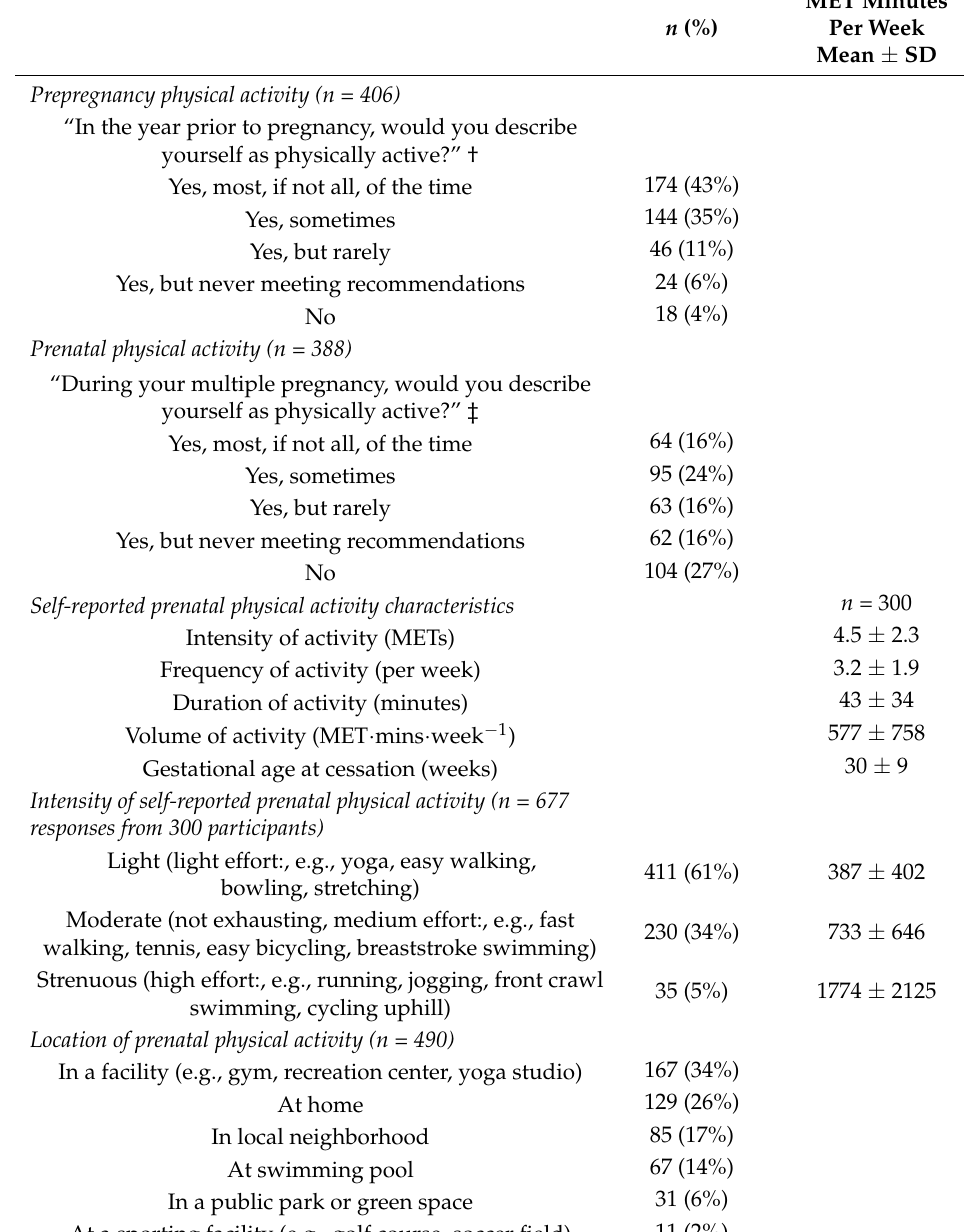
Table 2. Self-reported physical activity prior to and during multifetal